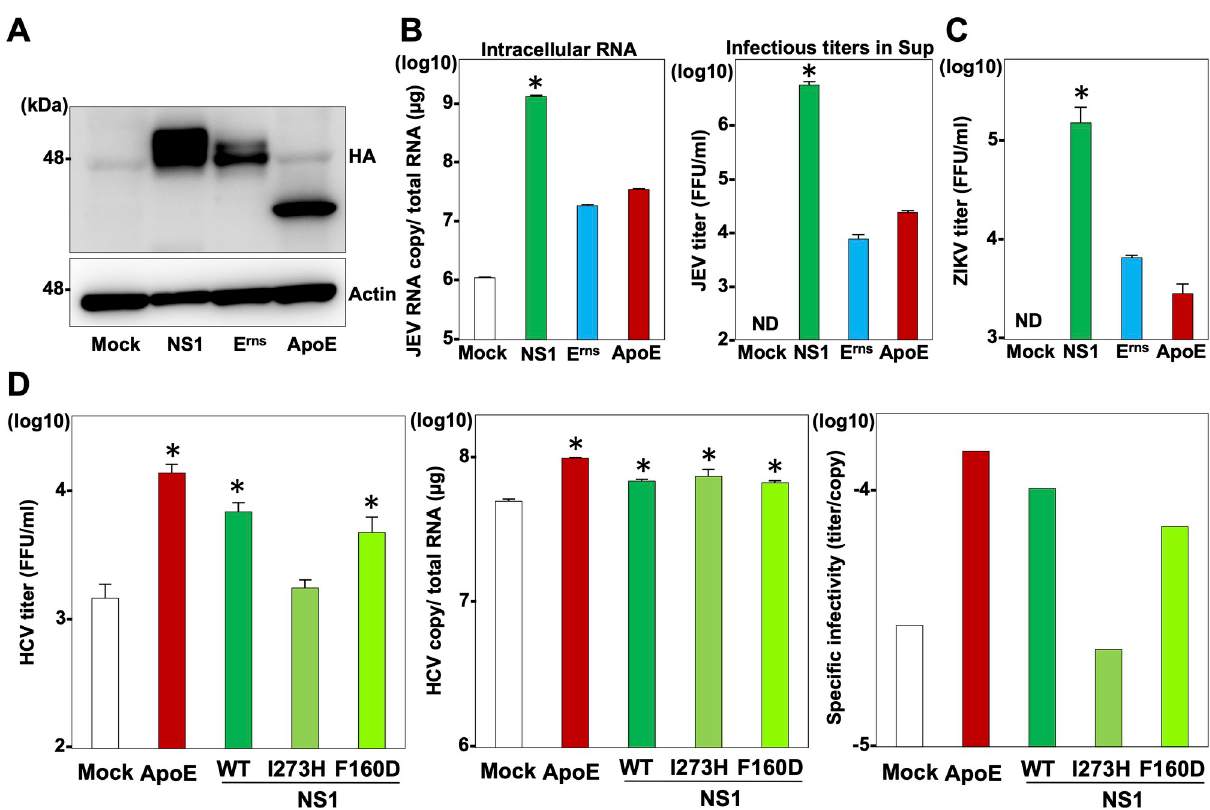
Fig 6. The secretory glycoproteins, including exchangeable apolipoproteins, pestivirus E rns , and flavivirus NS1, have a common role in the infectious particle formation of Flaviviridae viruses. (A) Expressions of NS1, E rns and ApoE were determined by immunoblotting at 48 hpi of lentiviruses into the BHK-21 cells. (B) At 96 hpi with JEV NS1 I273H , intracellular JEV RNA and infectious titers in the supernatants were determined by qRT-PCR and focus-forming assay, respectively. (C) At 96 h after infection with ZIKV NS1 I273H , infectious titers in the supernatants were determined by focus-forming assay. (D) ApoB and ApoE double-knockout Huh7 cells expressing either ApoE, wild type NS1or mutant NS1 (I273H and F160D) were infected with HCV. Infectious titers, intracellular RNA copies and specific infectivity were determined at 3 days post-infection. Statistical significance was assessed using one-way ANOVA with Dunnett’s test (B, C, D) and is indicated by asterisks ( � ) (versus control cells).